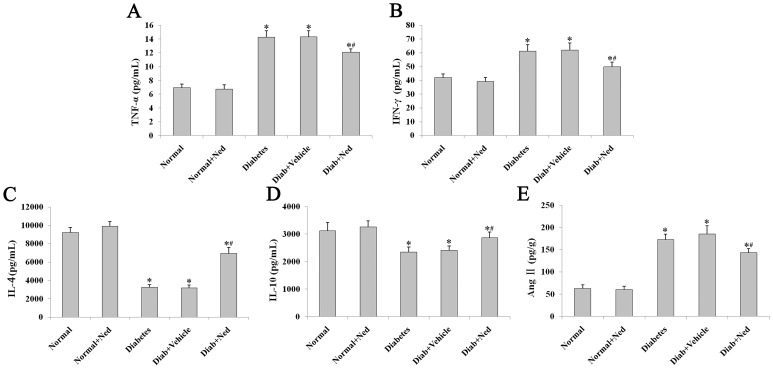
ELISA assay for cytokine expression in cardiac tissues of normal and STZ-induced diabetic mice treated with nedocromil (Ned) or controls.The graphs show the quantitative levels of (A) TNF-α, (B) IFN-γ, (C) IL-4, (D) IL-10, and (E) Angiotensin II (Ang II) of the indicated sample groups. Quantitative data are displayed as means ± SD (n = 15 per group). *P<0.05 vs. untreated normal group; #P<0.05 vs. untreated diabetic group.